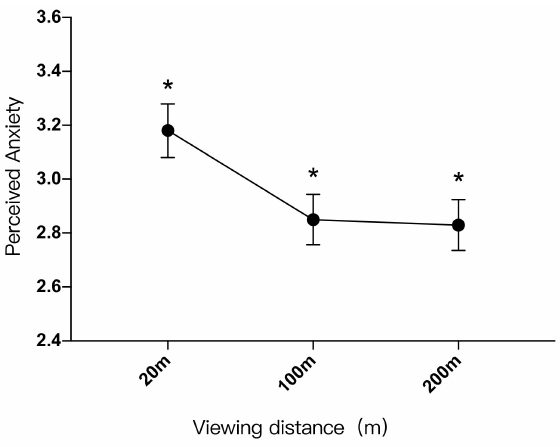
Figure 7. Impacts of different viewing distances on perceived anxiety, *: p <